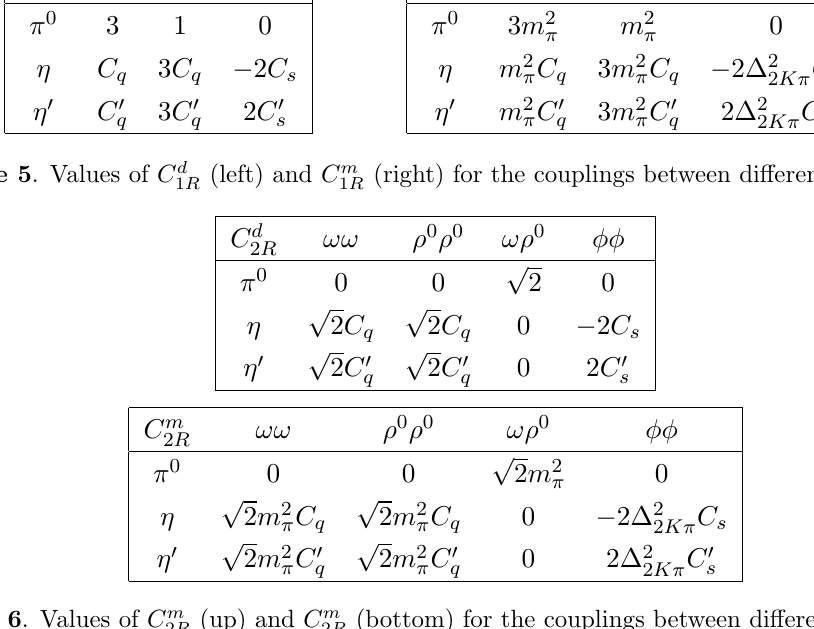
(up) and C m (bottom) for the couplings between di(cid:11)erent mesons. 2 R 2 R